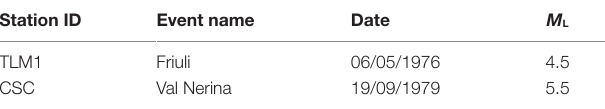
TaBle 5 | ground motion